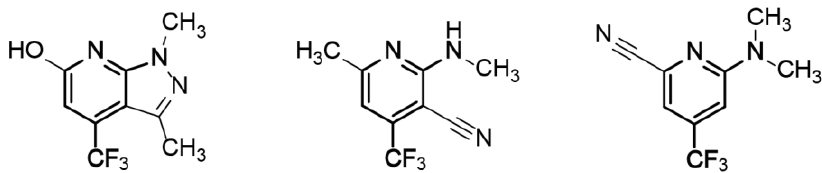
Figure 6 . Three binding fragments exhibiting a common scaffold (highlighted in